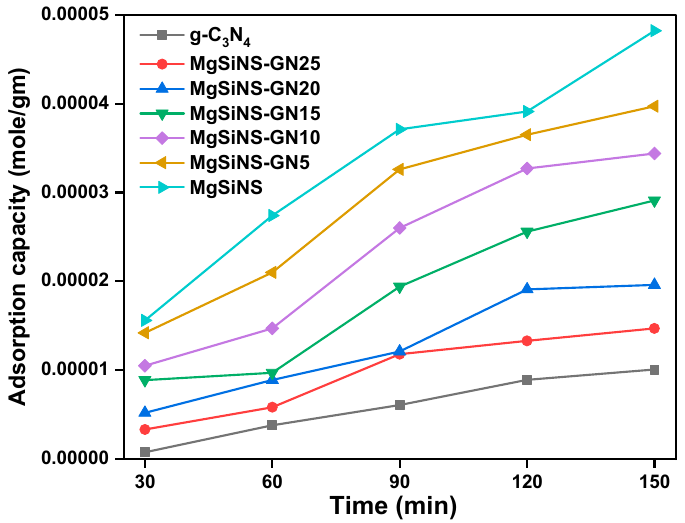
Figure 10. Pb +2 adsorption capacity of g-C 3 N 4 , MgSiNS, and MgSiNS-GN composites after 150